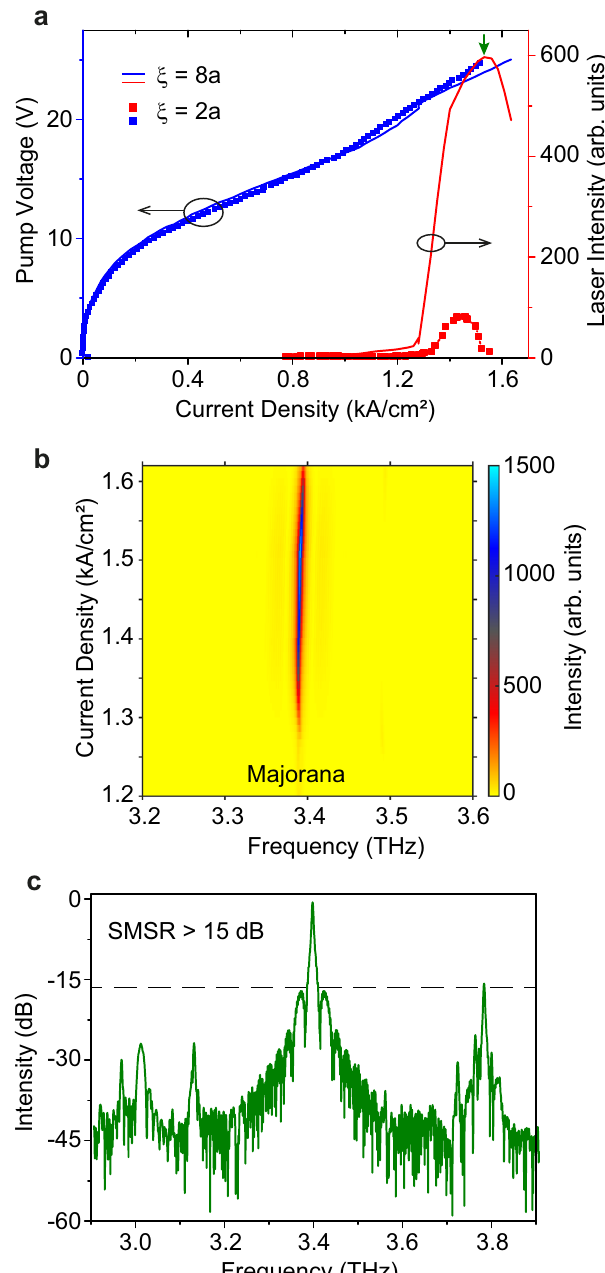
Fig. 5 | Power scaling of the THz topological MZM laser with a larger size. a MeasureL-I-V cures of topologicalMZM lasers with vortexcoreradius ξ =8 a and ξ =2 a ,thelightemissionisenhancedabout8-foldforthelarge-areadevice( ξ =8 a ). b 2D spectrum mapof the laseratdifferentpump currentdensities.A stablelasing peak is clearly observed at around 3.4THz. c The lasing spectrum obtained at its